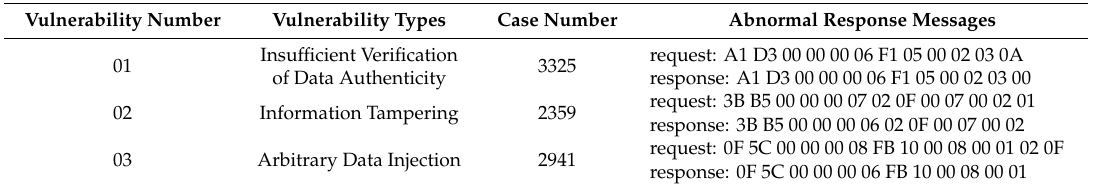
Table 2. Request and response detection results of Modbus TCP